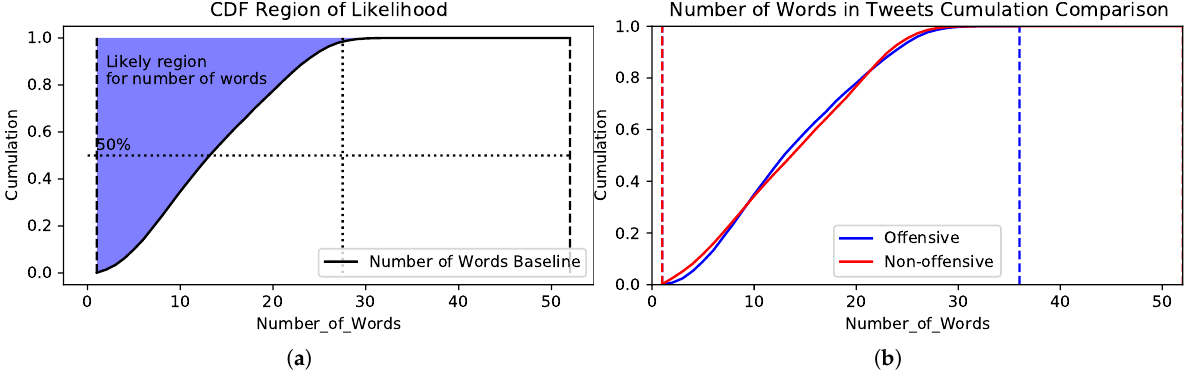
Figure 4. The cumulative distribution function for both classes where the majority of tweets have less than 20 words and the accumulation comparison for offensive and non-offensive classes in terms of the number of words in tweets. ( a ) The cumulative distribution function for both classes. ( b ) The accumulation comparison for offensive and non-offensive classes in terms of the number of words in